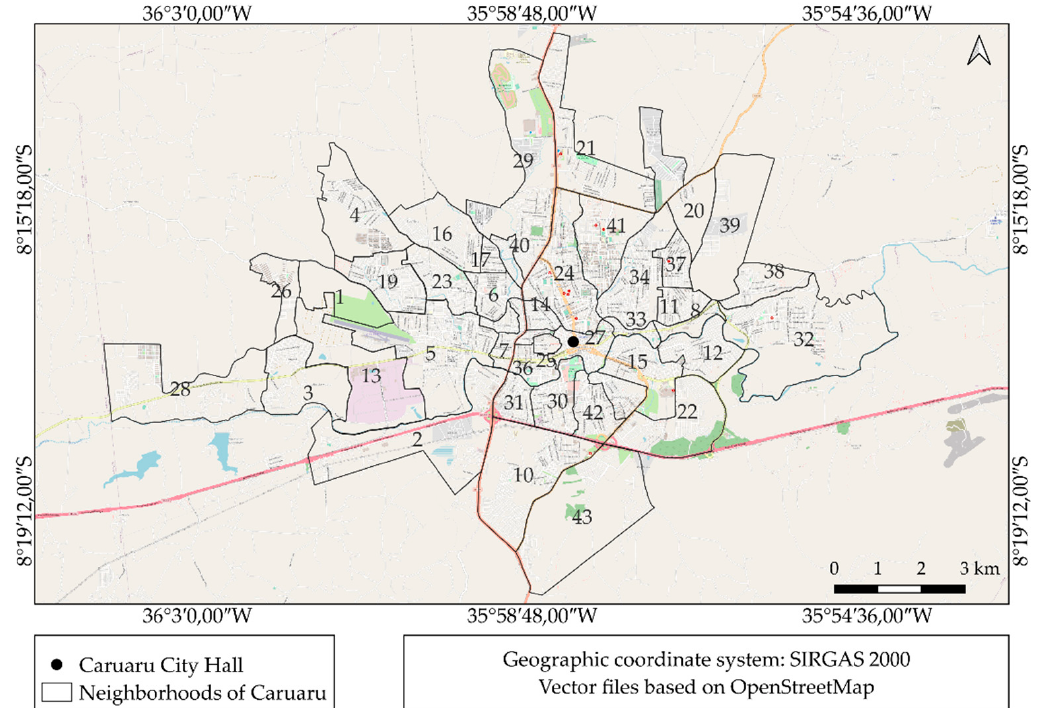
Figure 2. Division of neighborhoods in Caruaru. Table 1. Nomenclature of the neighborhoods of Caruaru.